Question: In a single sentence, describe what this figure presents.
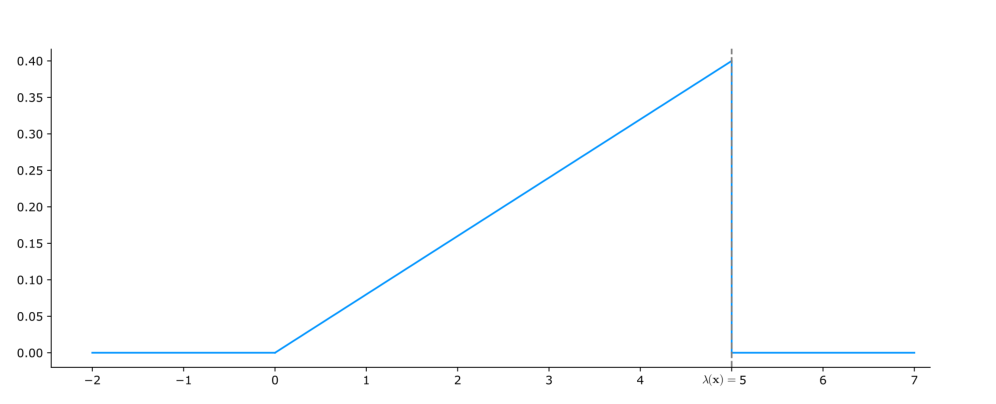
Answer: Probability density function of the triangular distribution (34) with (conditional) width parameter λ(x) = 5.